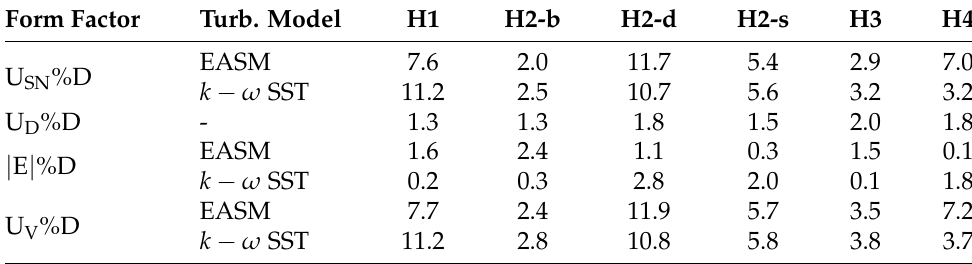
Table 2. Validation of the CFD based form